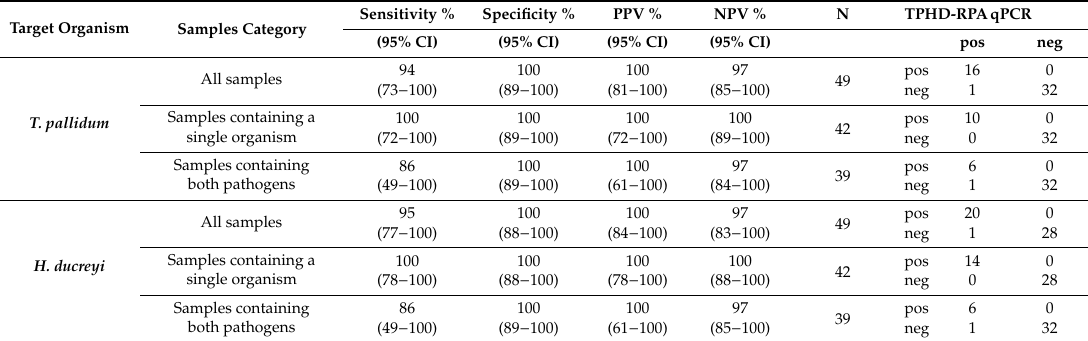
Diagnostic Performance of TPHD-RPA Assay as Compared to Multiplex qPCR for Each